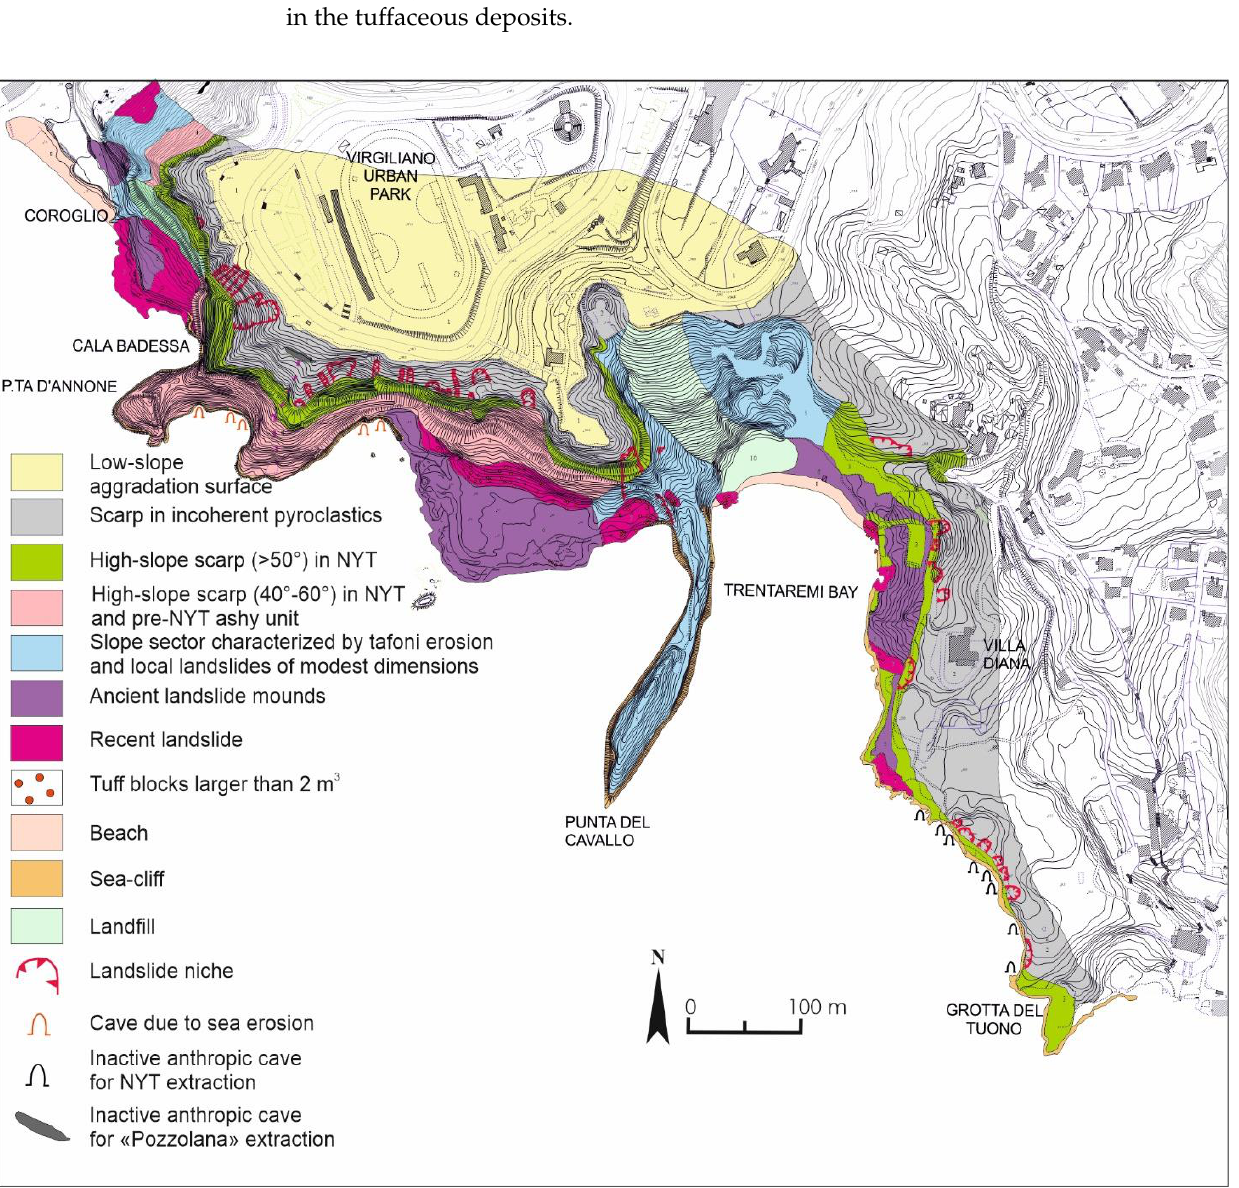
Figure 6. Geomorphological map of the Coroglio-Trentaremi area.